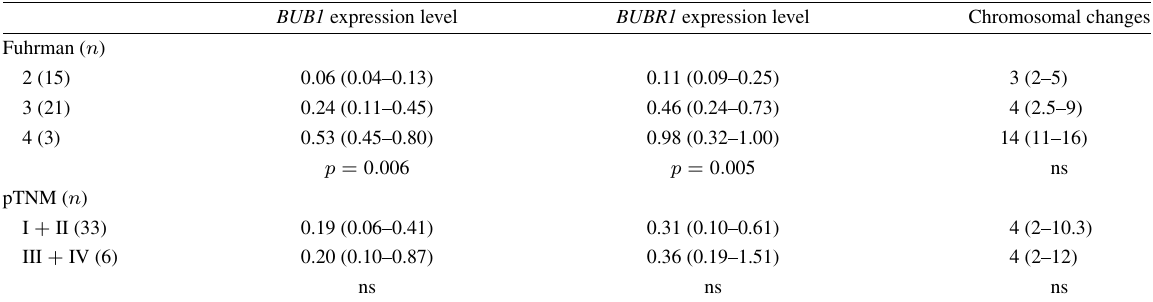
Association between BUB1 and BUBR1 expression levels and chromosomal alterations with Fuhrman grade and pTNM